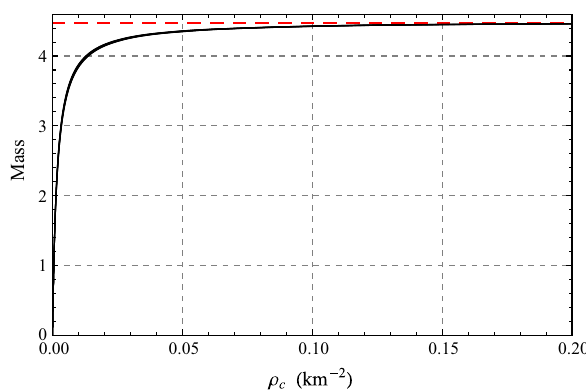
n 24 Red n 12 Dashed